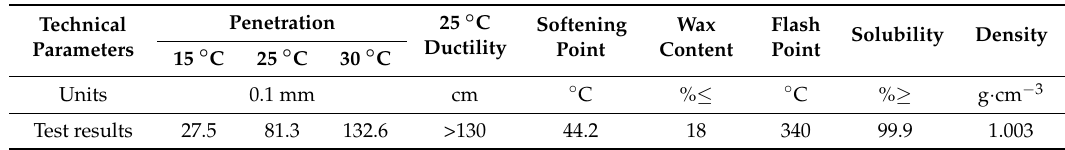
Table 2. Technical parameters of